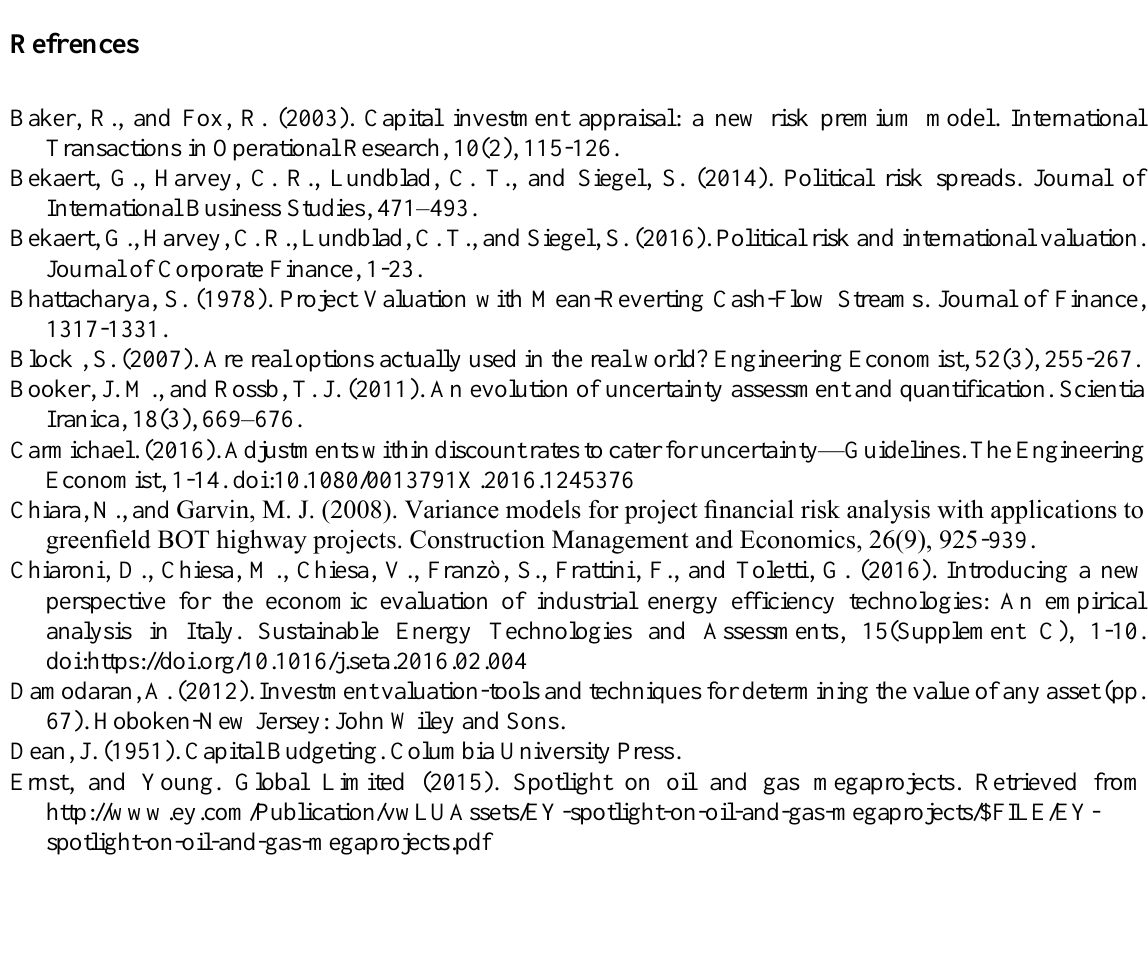
Table 7. Comparing the reliability of different approaches of valuation in predicting profitability of Soroush and Nowrouz development project Method Profitability index Result Actual outcome NPV NPV>0 Invest Wrong DNPV DNPV>0 Invest Wrong M-DNPV Do not Invest